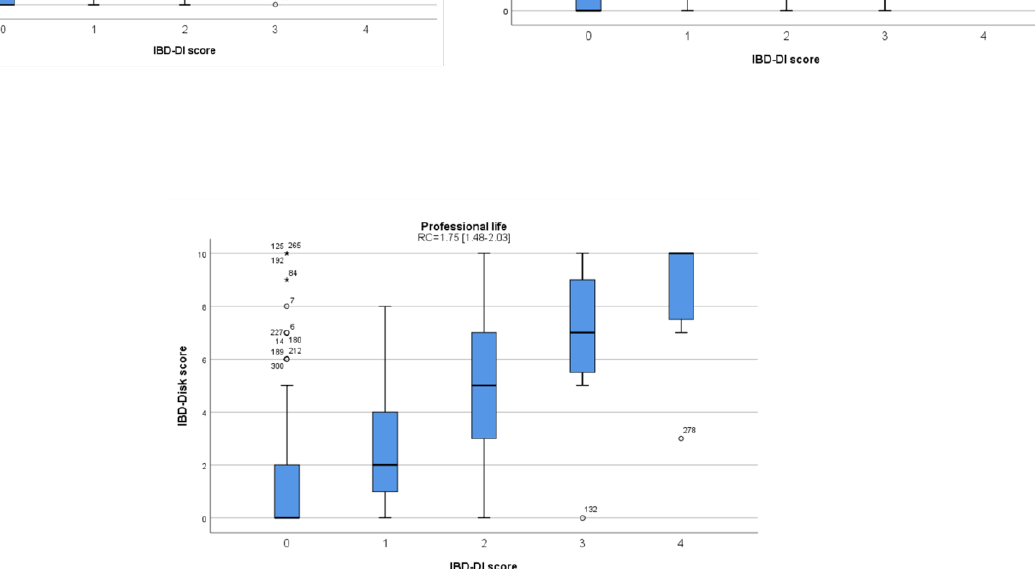
Table 2. “Test-retest” reliability of the IBD-Disk: Intraclass correlation coefficients for each item and the total IBD-Disk score ( n = 300).